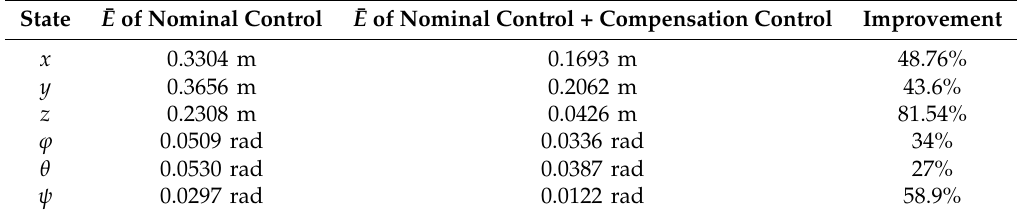
Table 2. The ¯ E of